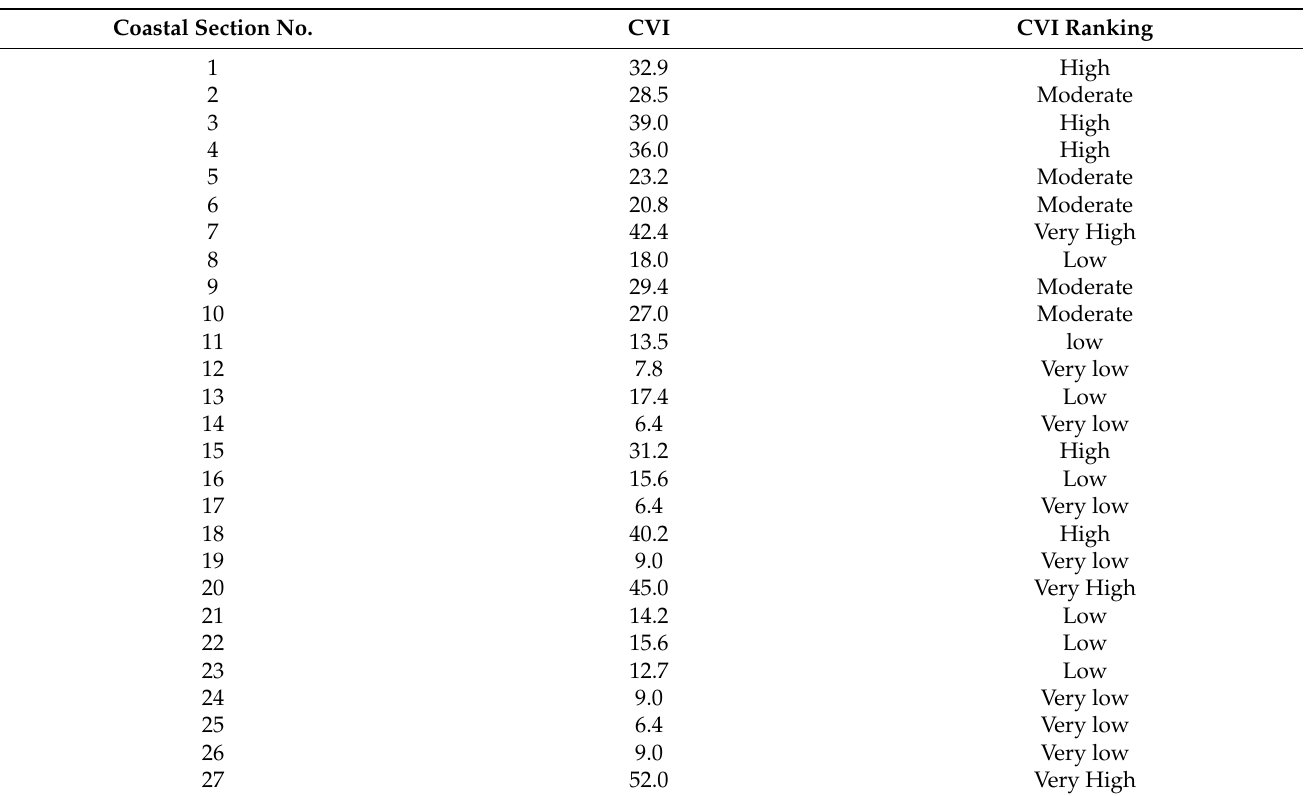
Table 4. CVI values and rankings for 27 coastal segments of the Iranian coast of Makran. Coastal Section